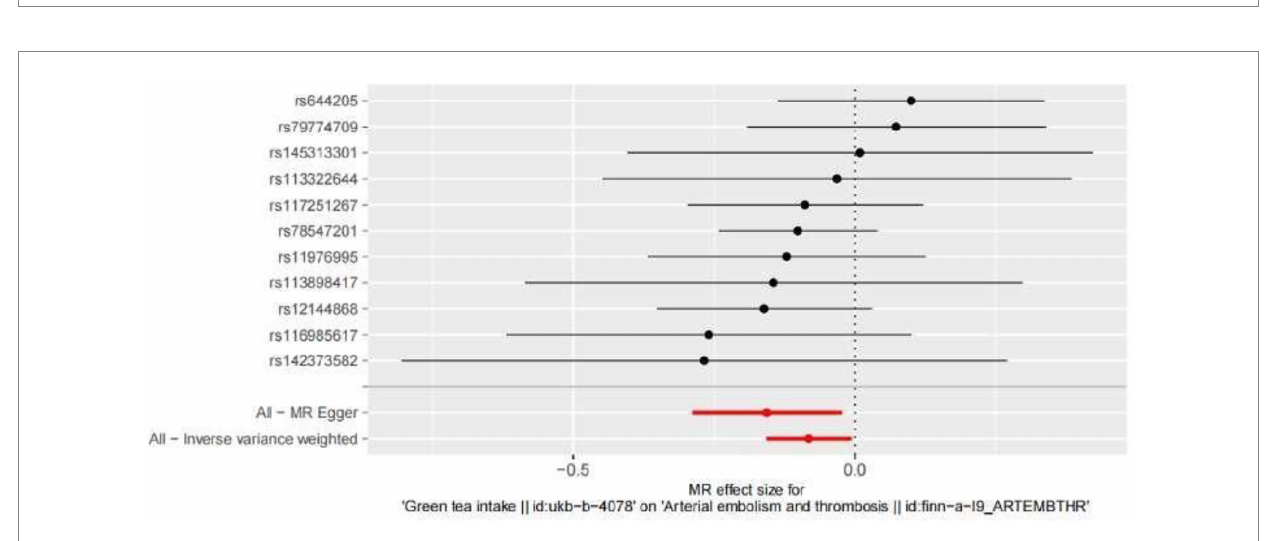
FIGURE 3 Forest plot to visualize the causal effect of every single SNP on ED. MR indicates Mendelian